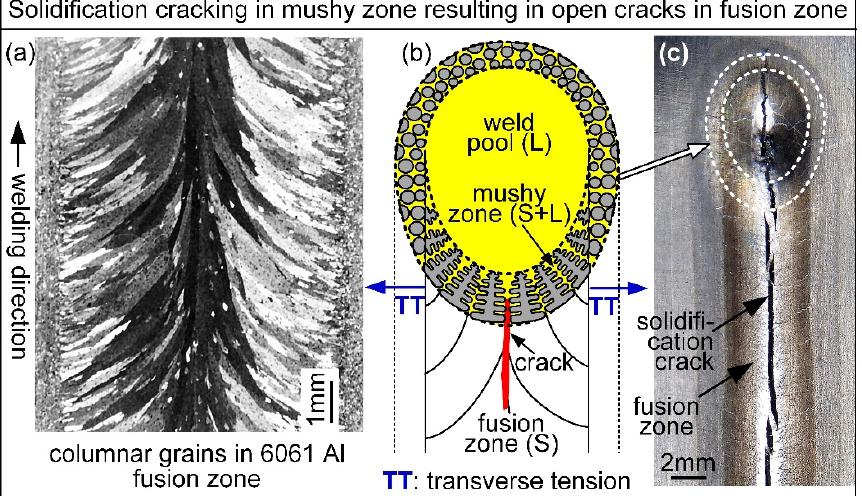
Figure 6. Solidification cracking: ( a ) columnar grains in 6061 Al near top surface of fusion zone; ( b ) cracking along grain boundary in mushy zone induced by transverse tension; ( c ) open cracks in 6061 Al bead-on-plate weld made by gas-tungsten-arc welding.